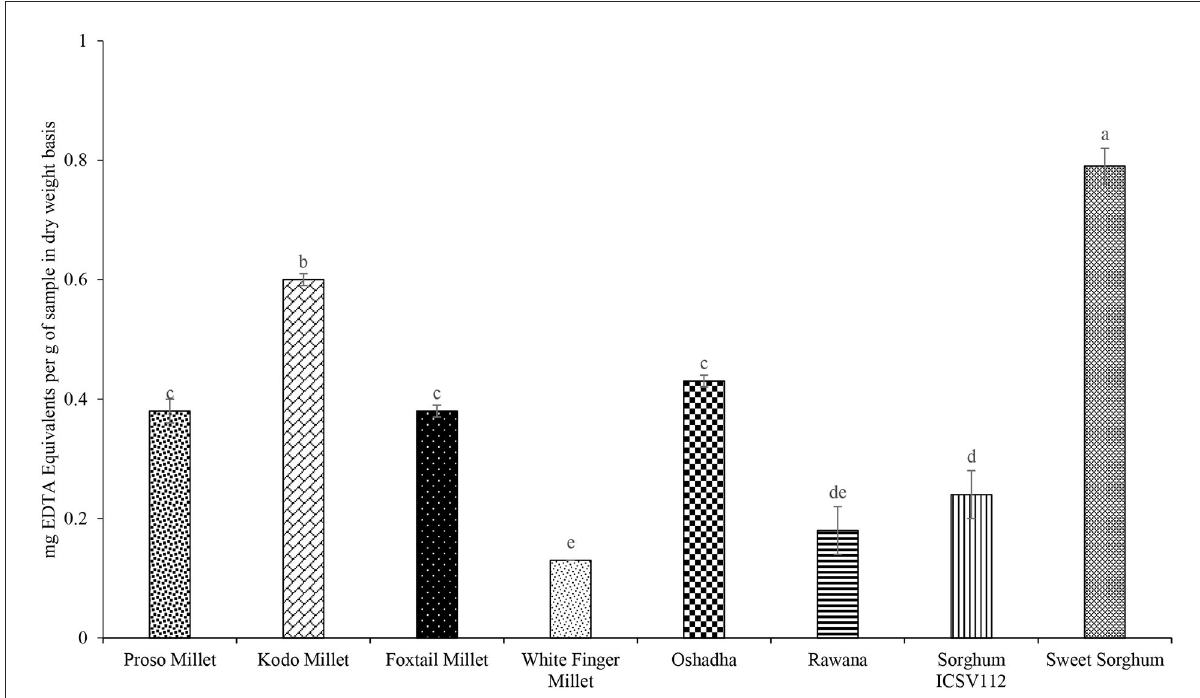
FIGURE9 Ferrous Ion Chelating Activity (FICA) of selected millet types and sorghum varieties. Different letters on bar graphs are significantly different at P <